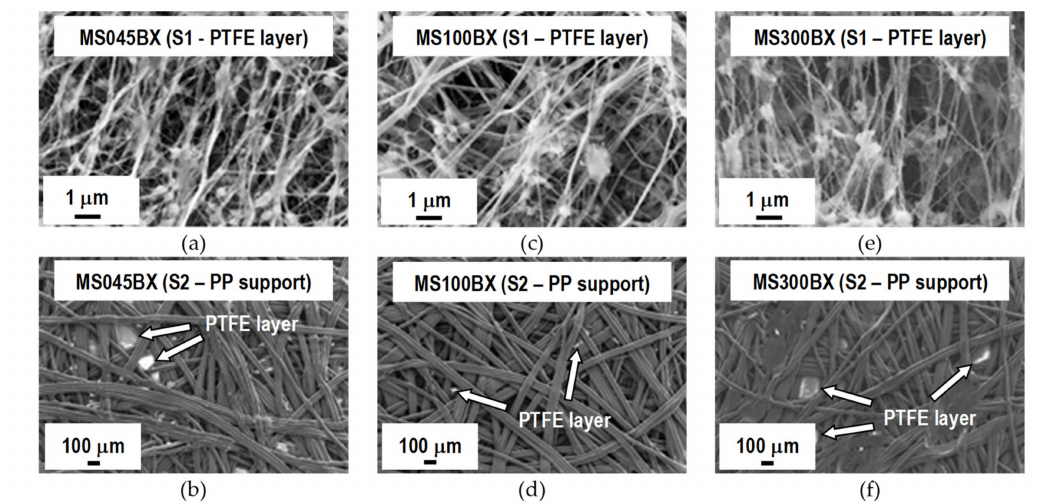
Figure 3. FESEM micrographs of the two surfaces (S1—PTFE layer and S2—PP support) of MS membranes. ( a , b ) MS045BX; ( c , d ) MS100BX; ( e , f ) MS300BX.